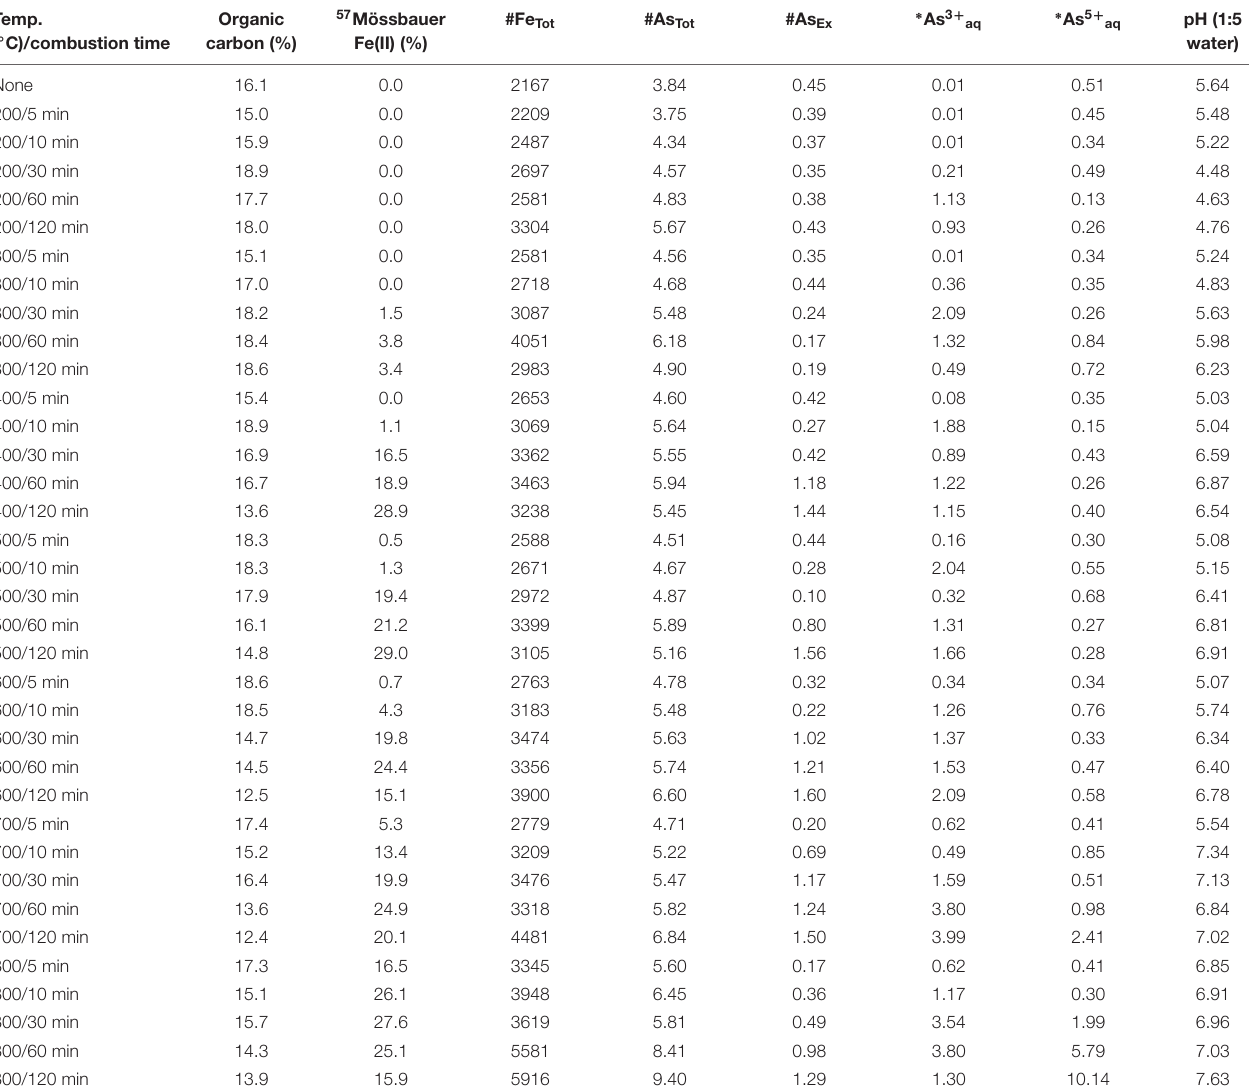
TABLE 1 | Characteristics of soil:ferrihydrite